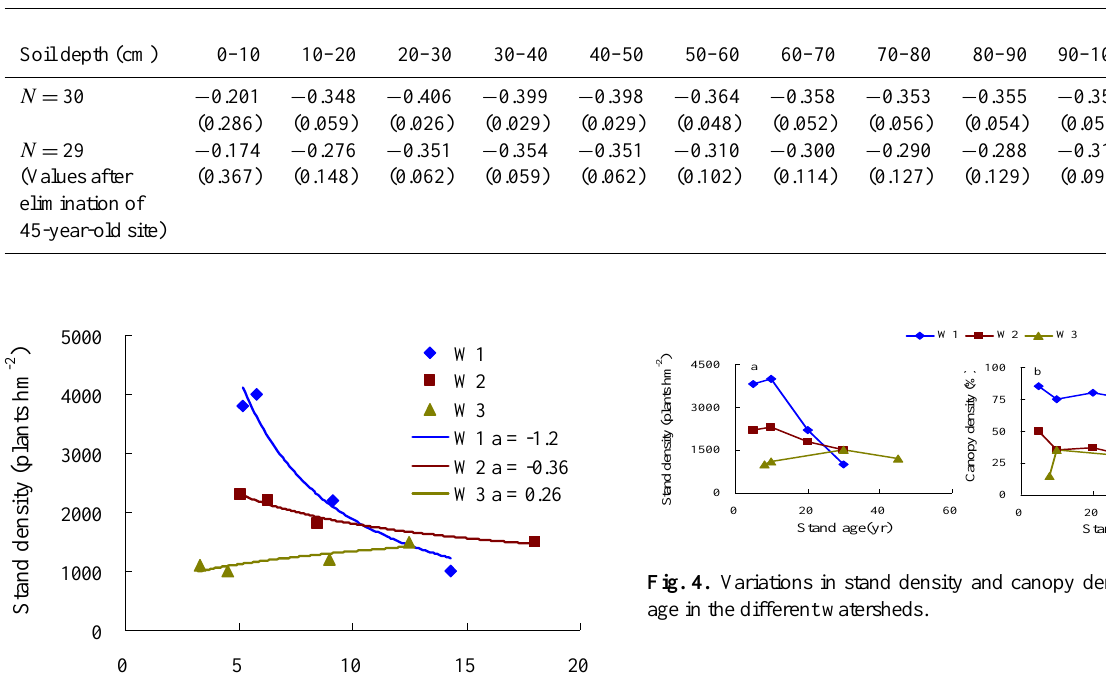
With a MAP of only 352 mm, W3 was the driest water- shed and was also the only one in which 45-year-old plant- ings were present. To eliminate any bias, the relationship between stand age and SMC was further examined after ex- cluding the 45-year-old site (Table 2). The SMC still had a negative correlation with stand age at the regional